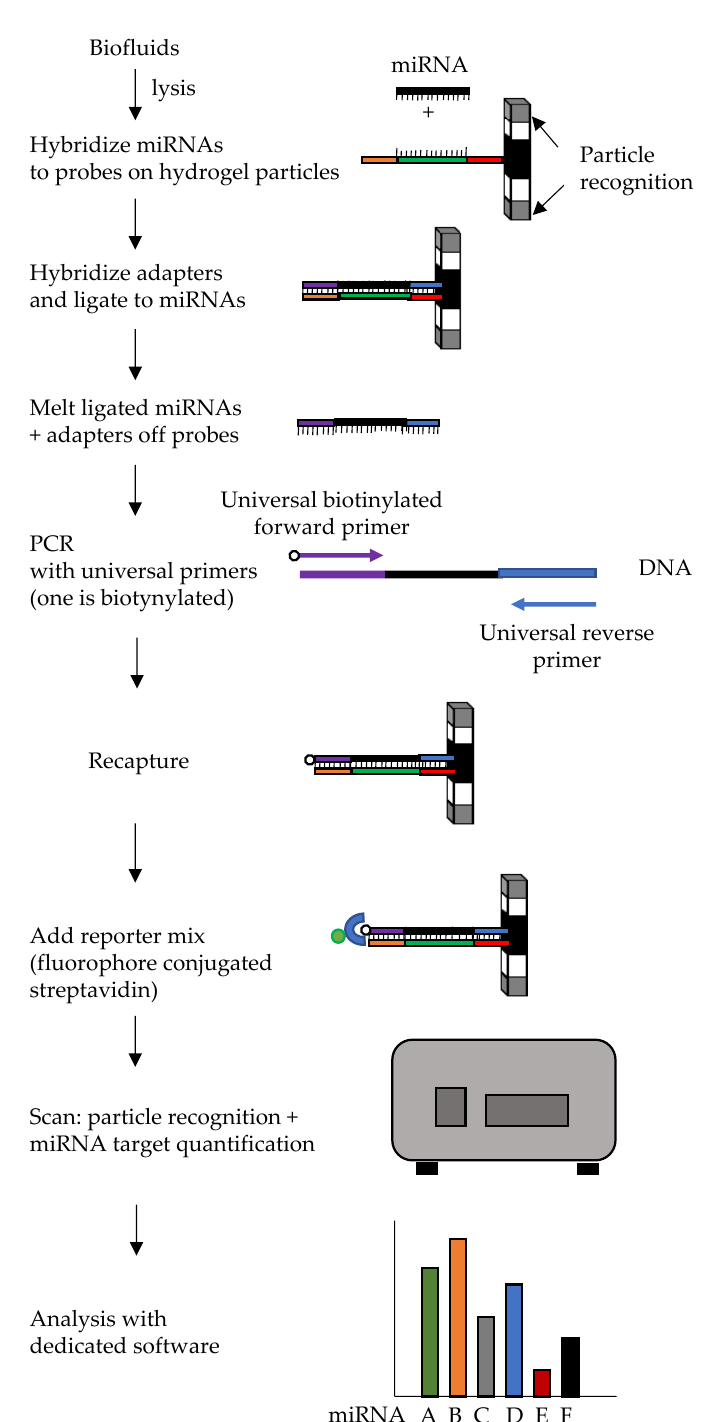
Figure 10. Diagram of Fireplex workflow. The hydrogel particle carries a combination of fluorophores at the two ends, for particle recognition by flow cytometry, and probes for miRNA capture and adapters ligation. For the sake of simplicity, only one probe is shown, but several identical probes are present on each particle, to bind a specific miRNA. The sequence hybridizing to the target miRNA is shown in green, the sequences hybridizing to the universal adapters that will be ligated to the miRNA are in orange and red. In each well particles for up to 65 different targets are present. Wash steps are not